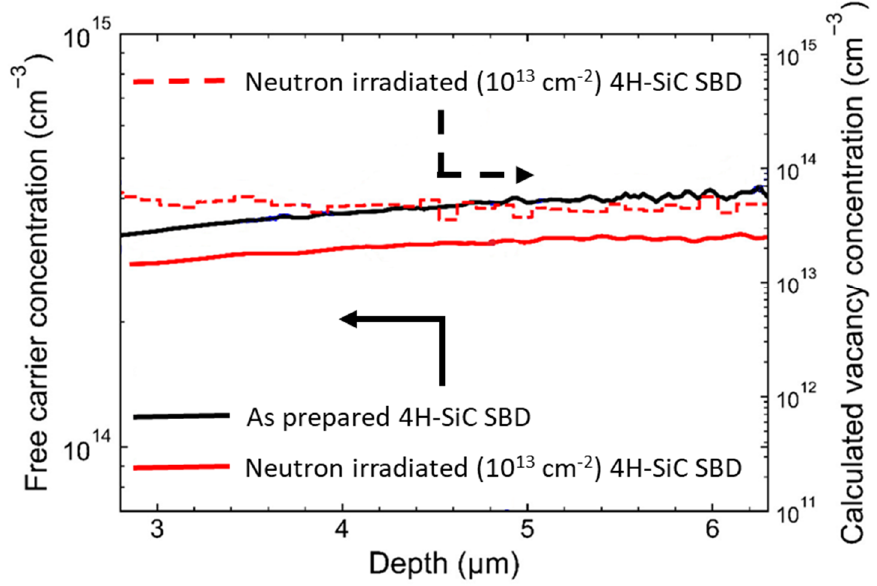
Figure 4. Free-carrier concentration profiles of as prepared and neutron-irradiated n-type 4H-SiC SBD (solid lines, left y -axis). The calculated vacancy concentration profile for neutrons using FLUKA software (red, dashed, right y -axis). The free carrier concentration profiles are obtained from the C–V measurements. Adapted from Ref. [22].